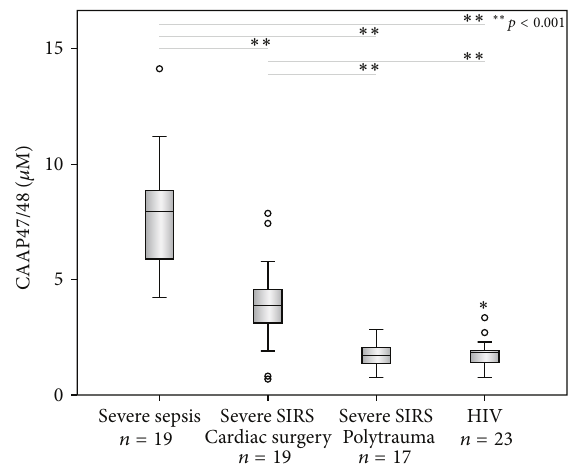
Figure 6: Boxplots of CAAP47/48 concentrations. Boxplots of CAAP48 concentrations in severe sepsisand SIRS patients following cardiac surgery and polytrauma are shown. CAAP48 concentra- tions comprise CAAP48 or CAAP47 concentrations for homozy- gous individuals and CAAP47/48 concentrations for heterozygous individuals. Circles represent mild outliers and asterisks extreme outliers. 𝑝 values for significant differences between groups are indi- cated with respective lines. Severe sepsis patients exhibit significant higher CAAP47/48 concentrations compared to the severe SIRS and HIV infected patients.